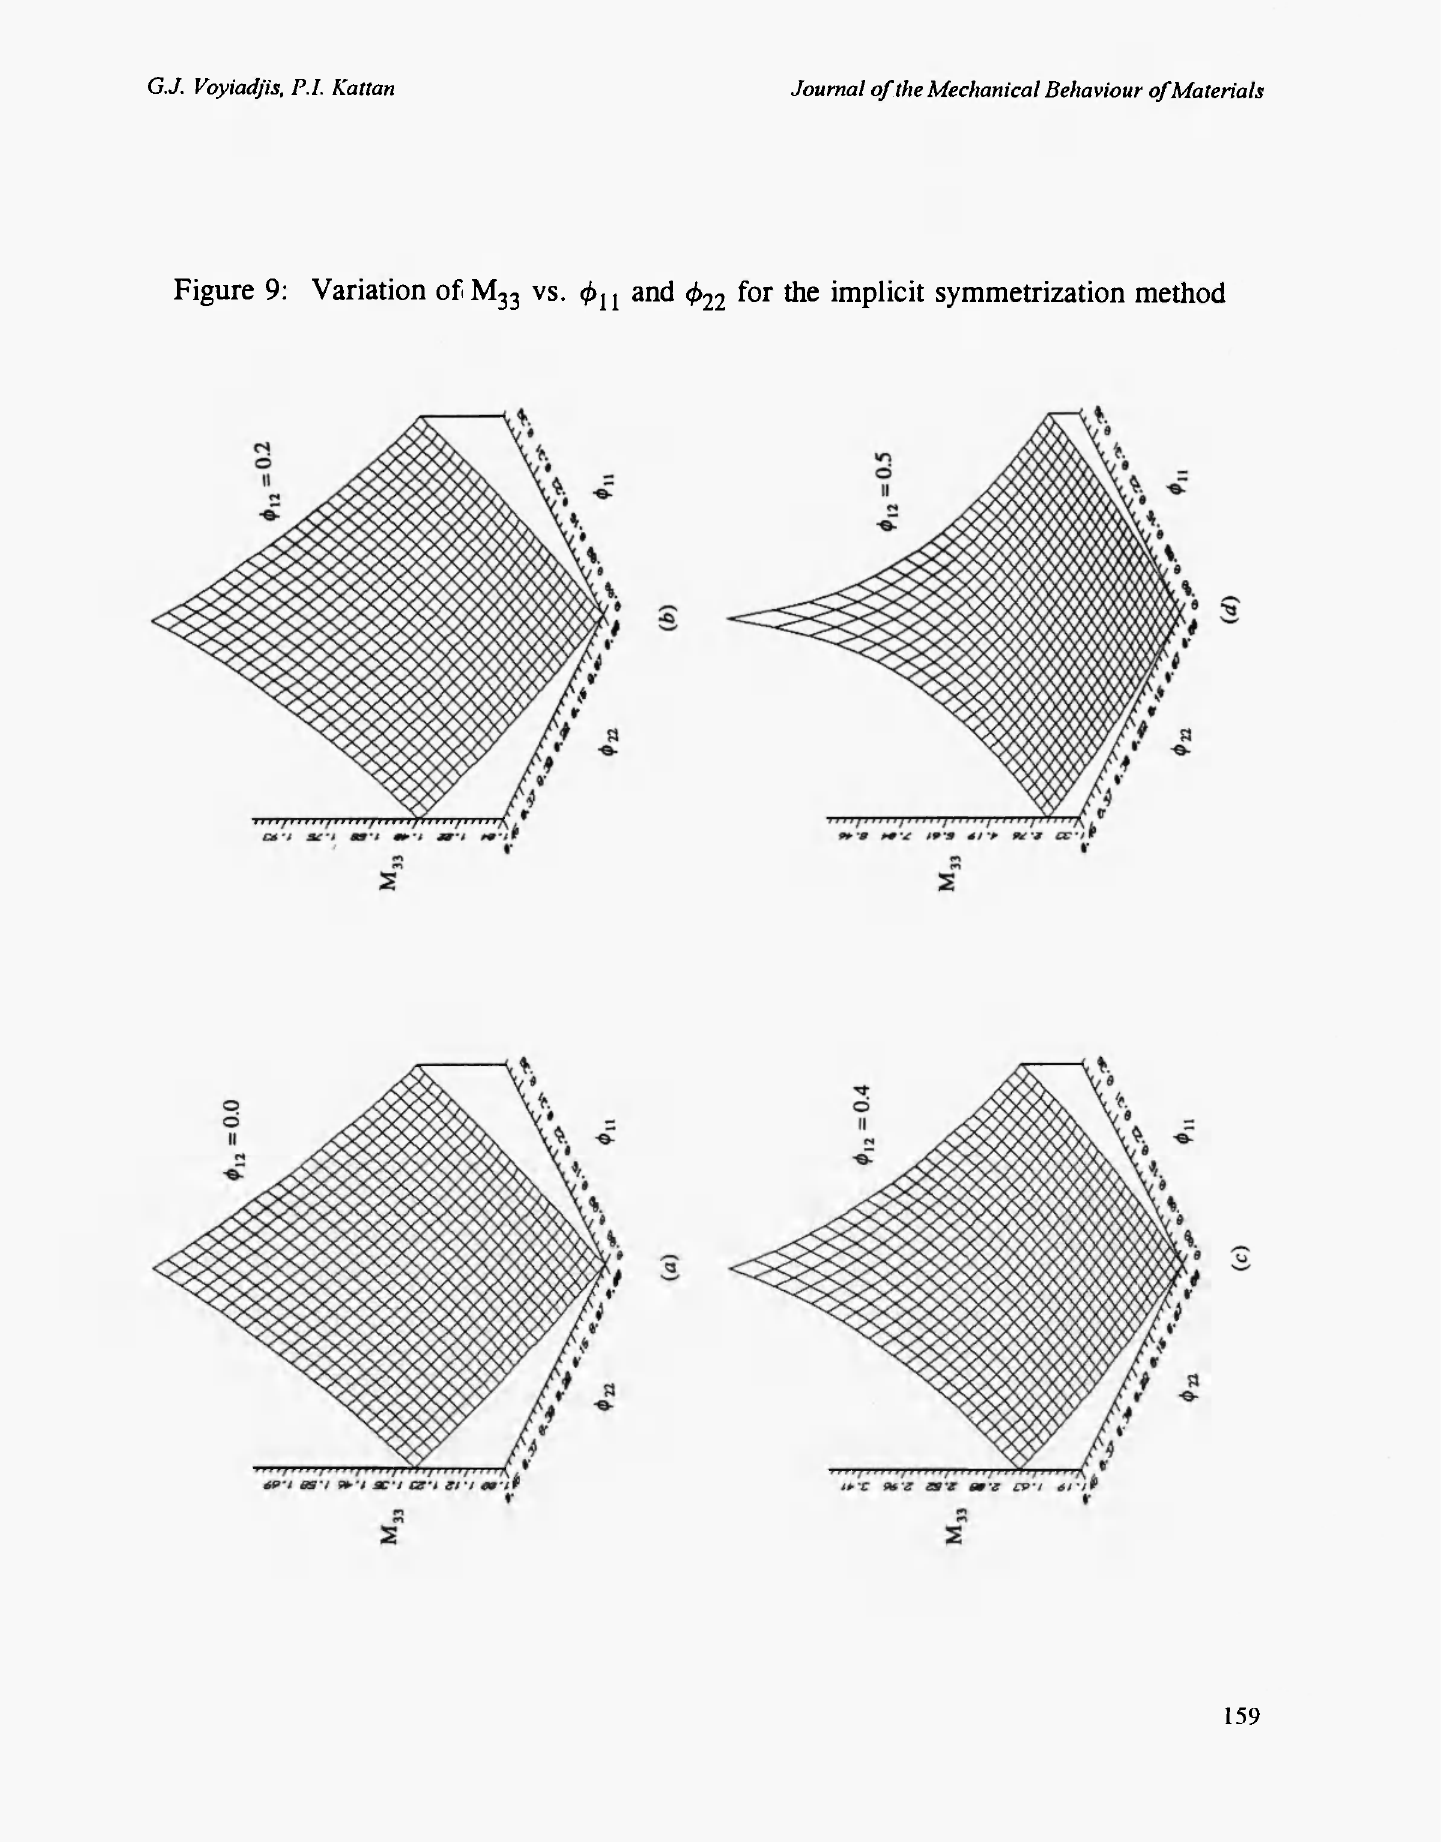
Figure 9: Variation of M